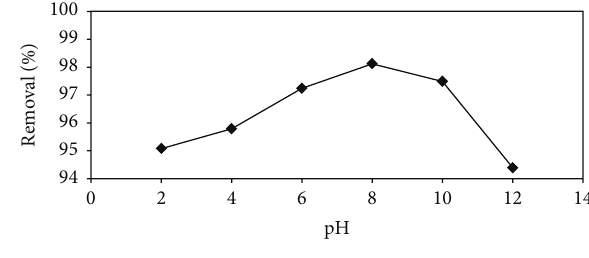
Figure 2: Effect of pH on RO16 removal.